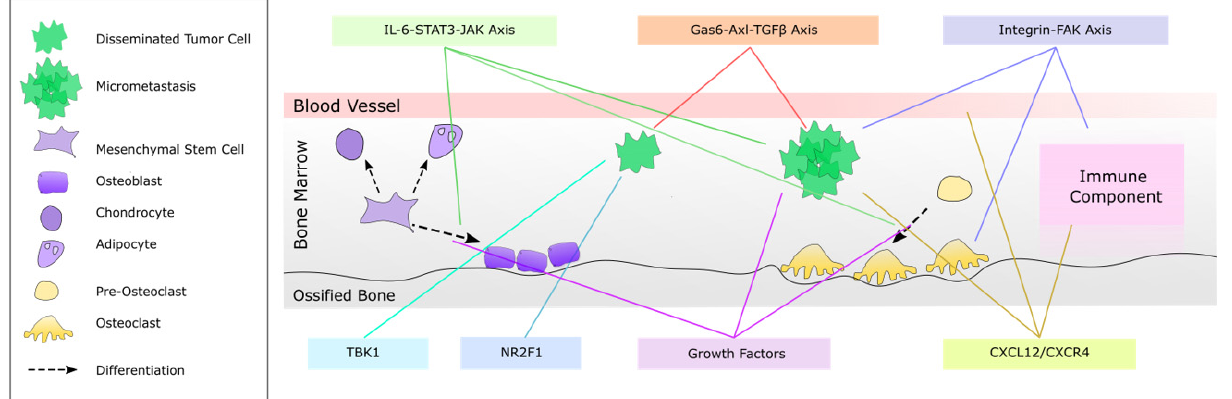
Figure 1. Cell–cell communication pathways as possible targets to prevent development of or treat bone metastasis. Bone metastasis is mediated by many tumor intrinsic factors, but also by cell–cell communication between tumor cells and bone resident cells. Precursor cells residing in the bone marrow can differentiate into immune cells or bone remodeling cell types such as osteoclasts and osteoblasts, which can either inhibit or promote tumor cell growth and progression into a micrometastasis. Cellular processes such as immunosuppression, bone remodeling or angiogenesis can also promote development of macrometastases in the bone, and often share regulatory pathways which could serve as very effective therapeutic